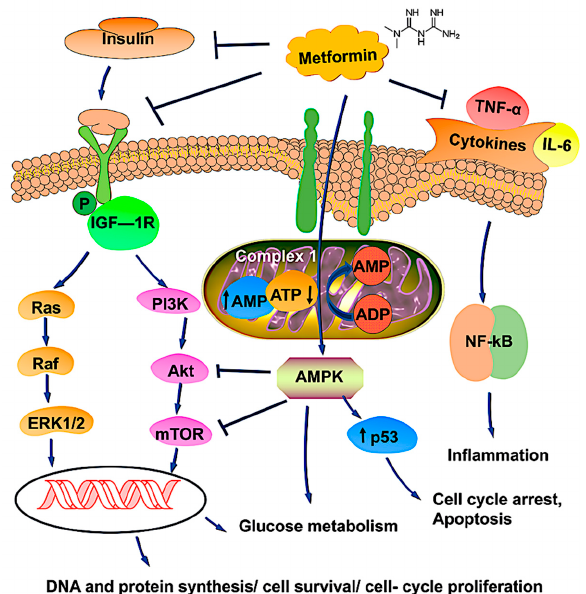
Figure 1. Schematic representation of metformin’s possible mechanism of action in OvCa therapy. Metformin, a first-line anti-diabetic drug, is likely to be associated with a reduced risk of cancer for those with T2DM. The most common pathway involves the activation of AMPK, which regulates energy metabolism by modulating complex 1 of the respiratory chain in mitochondria by changes in the AMP/ATP ratio. Activated AMPK upregulates the tumor suppressor gene p53, which induces apoptosis and cell cycle arrest. Metformin binds with insulin, IGF, and cytokine receptors and mod ‐ ulates pathways involved in tumor progression. Upon binding, metformin inhibits the PI3K/AKT/mTOR and Ras/Raf/ERK pathways, leading to reductions of DNA synthesis and cell pro ‐ liferation, thereby causing tumor cell death. Metformin, through AMPK activation and mTOR inhi ‐ bition, could increase glucose uptake and glycolysis. Overall, metformin promotes phosphorylation, blocking nuclear translocation and impairing gene transcription, processes involved in cell survival, gluconeogenesis, and protein synthesis. The arrows ↑ and ↓ indicates upregulation and downregu ‐ lation, respectively.